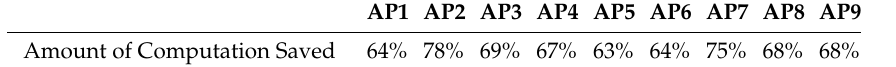
Figure 5. Comparison of the number of distinct RSS values on each AP between the raw and processed samples.